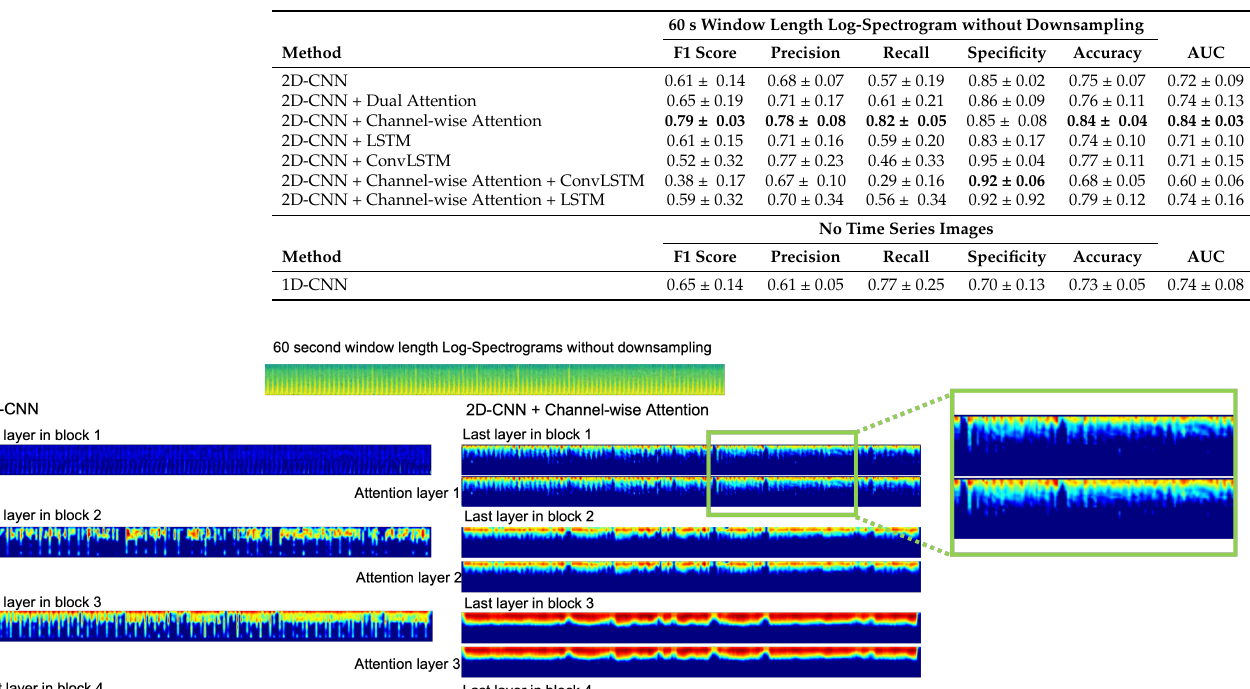
Table 1. Quantitative comparison on the proposed 2D-CNN + Channel-wise Attention method and the baseline methods. The results are presented as mean ± standard deviation. The best performance is indicated in bold.